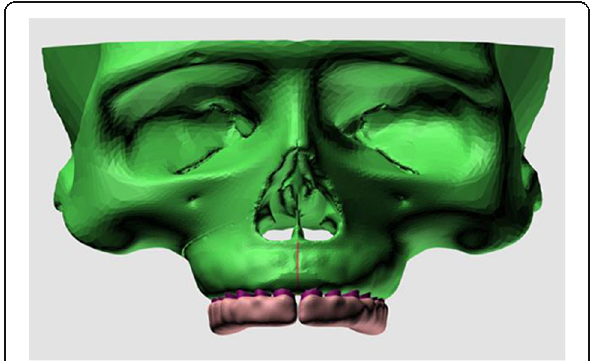
Fig. 4 Final finite element model used in the